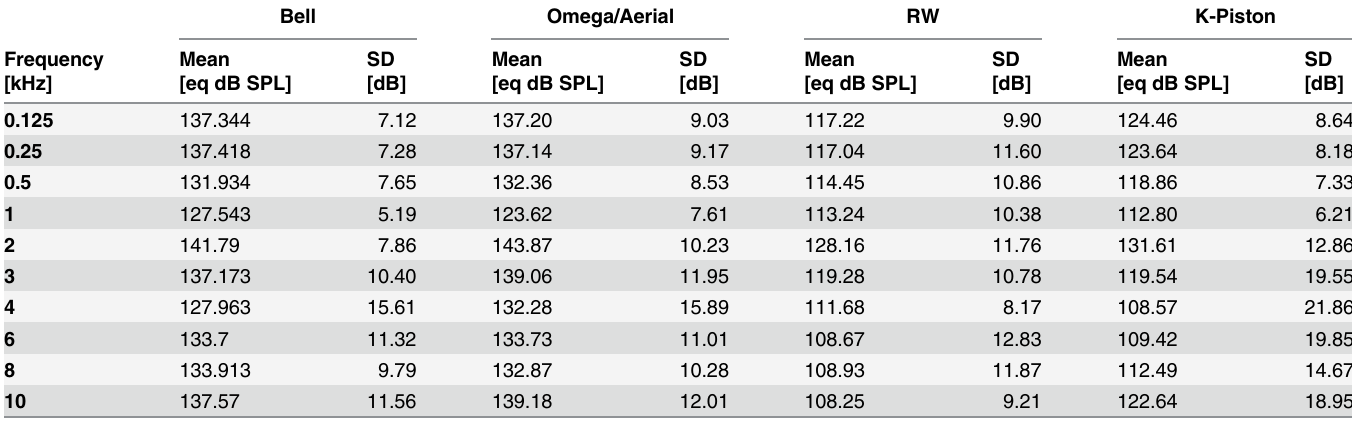
Table 1. Mean equivalent output levels and standard deviations of all stimulation modes tested.